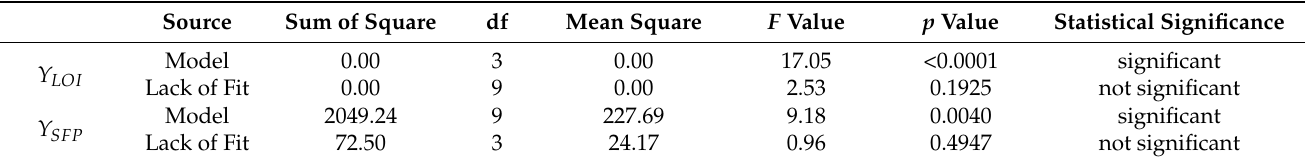
Table 6. Variance analysis of the flame retardant performance fitting model.